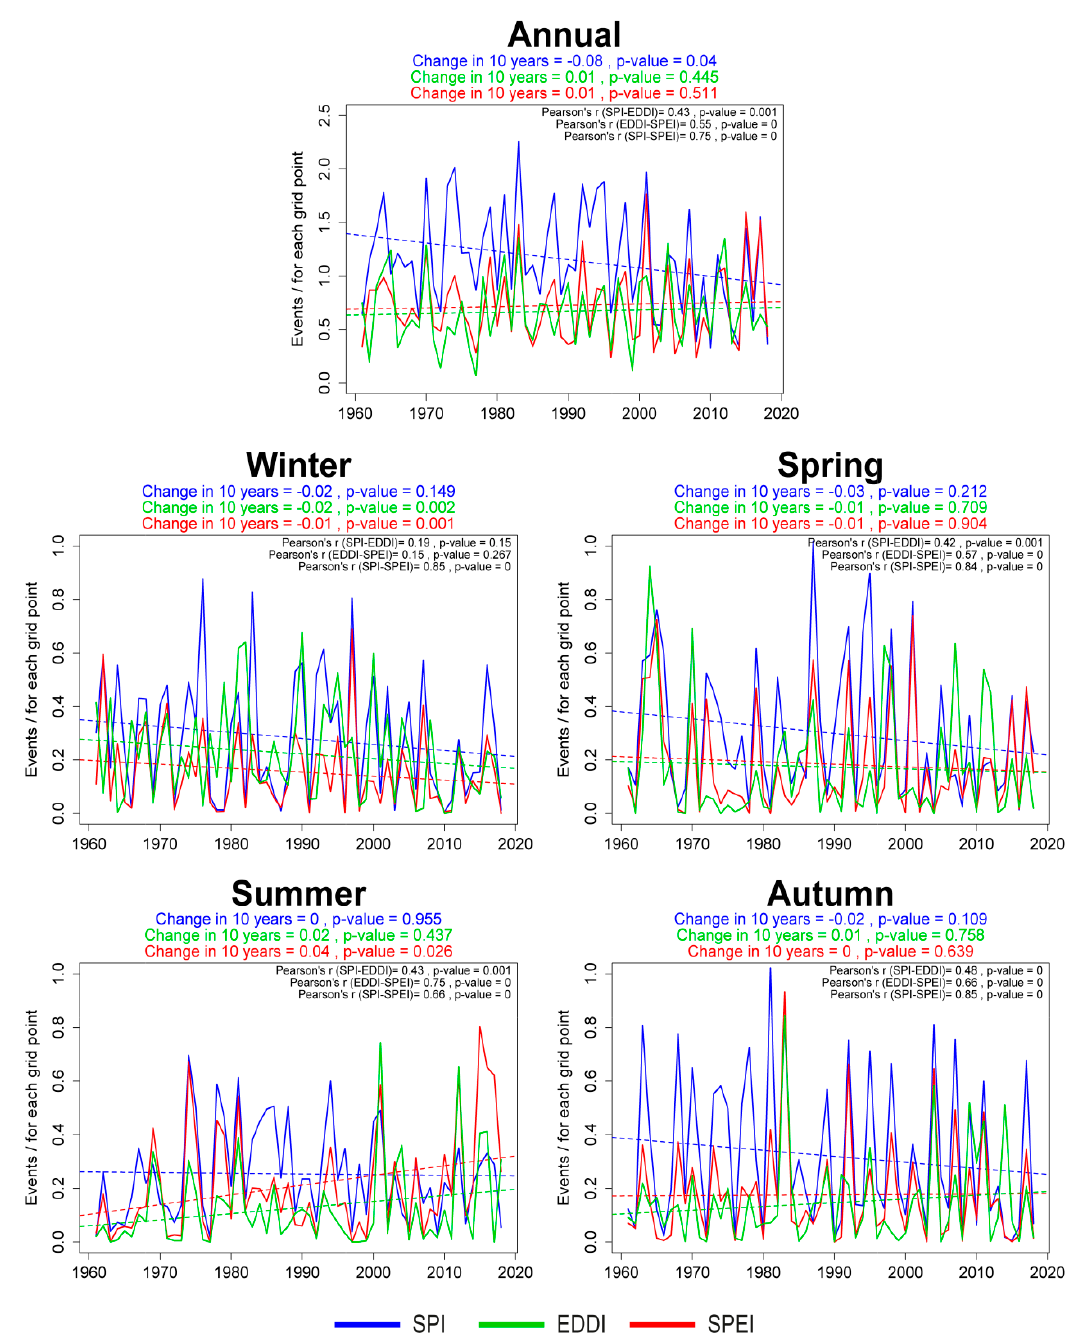
Figure 6. Temporal evolution of the average frequency of flash droughts identified by the SPI, SPEI, and EDDI on mainland Spain and the Balearic Islands over the period 1961–2018 at an annual and seasonal scale.